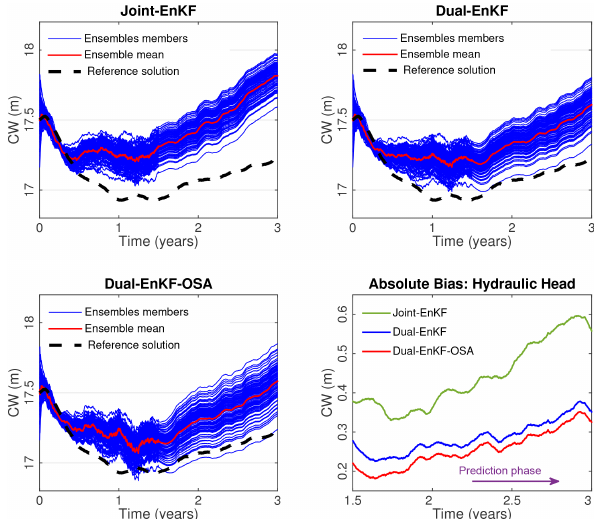
Figure 10. Left panel: ensemble variance map of the initial conduc- tivity field. Right sub-panels: ensemble variance maps of estimated conductivity after 6 and 18 month assimilation periods using the dual EnKF and the proposed dual EnKF OSA schemes. These re- sults are obtained with 100 members, 5 days of sampling period, nine observation wells, and 0.10m as measurement noise.